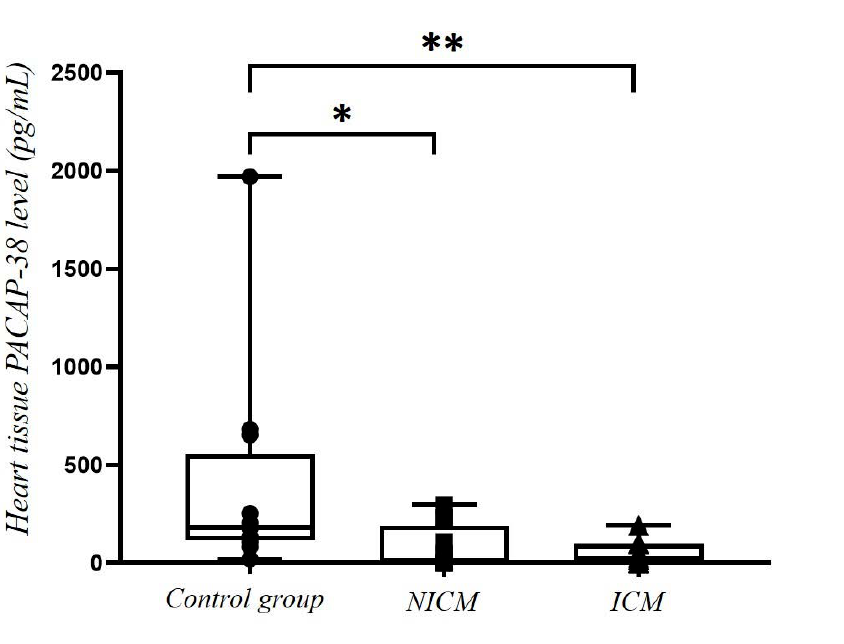
Figure 6. Tissue PACAP-38 levels in heart tissue samples from patients with non-ischemic cardiomy- opathy (NICM, n = 11) or ischemic cardiomyopathy (ICM, n = 12) and from the healthy control group ( n = 12). The box plot diagram represents the interquartile range, median values. The individual values are presented with black dots (control group), squares (acute HF) or triangles (chronic HF). Statistical analysis was performed with one-way ANOVA test with Tukey post-hoc test.* p < 0.050, ** p < 0.001 vs. control